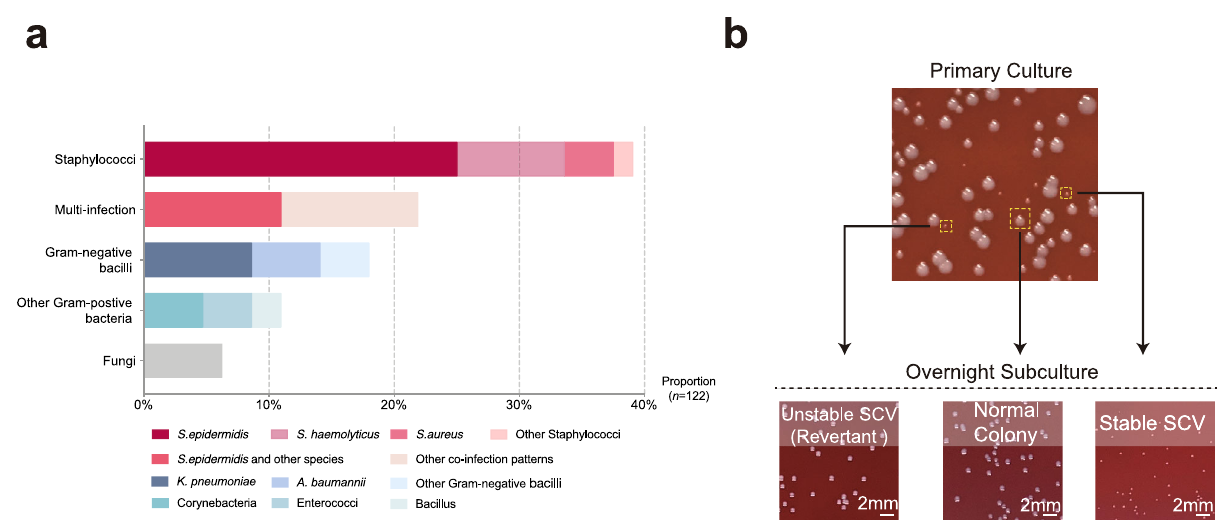
Fig. 1 Recovery of SCV from clinical catheter infections. a Overview of pathogens responsible for a total of 128 cases of catheter infections. Multinfection: no less than two species were isolated from the same catheter. b Photographs of initial culture from a representative S. epidermidis -infected catheter specimen after overnight incubation on sheep blood agar and subcultures of three characteristic colonies after 24-h incubation. The bars equal 2 mm. Table 1 Baseline features of patients with staphylococcal catheter infections. Cases with stable SCV Cases with unstable SCV Cases without SCV P value